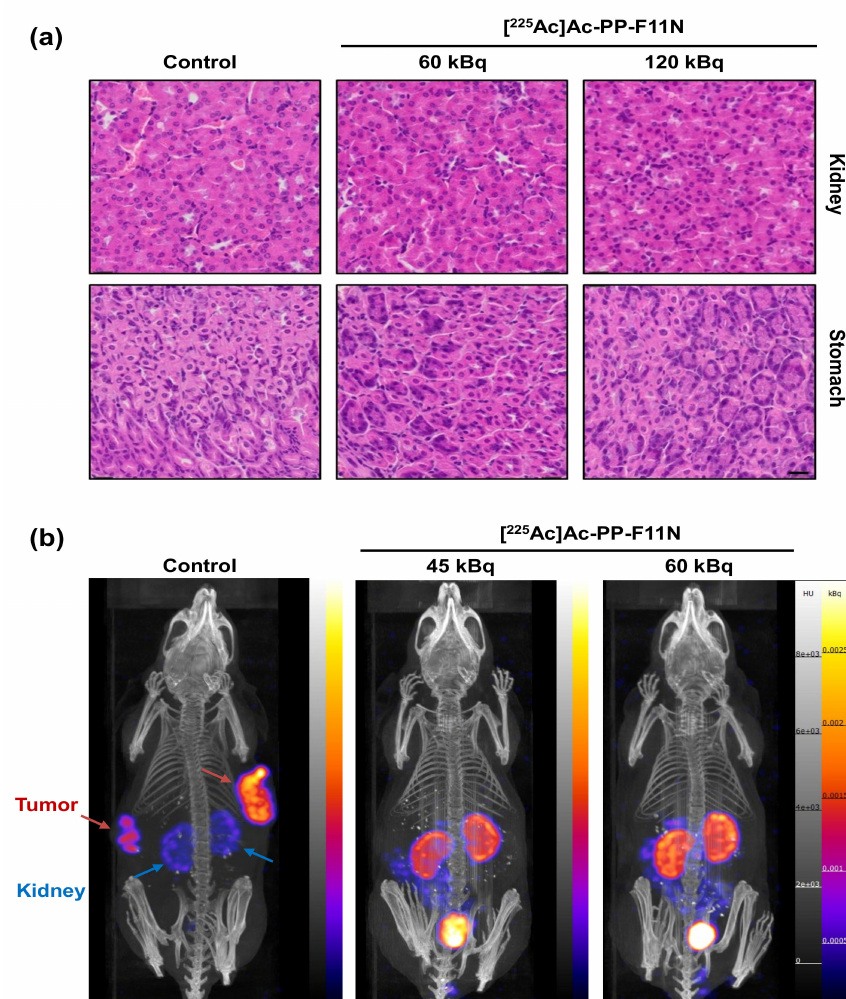
Figure 4. Histological analysis of the kidney and stomach sections an d SPECT / CT imaging after TA ( a ) Representative images of HE stains of the organs isolated from the control, 60, and 120 kBq [ 225 Ac]Ac-PP-F11N-treated A431 / CCKBR xenografted nude mice. Scale bar: 20 µ m. ( b ) SPECT-CT image (left) 20 h post-[ 111 In]In-PP-F11N injection of untreated A431 / CCKBR tumor-bearing mouse. Red and blue arrows indicate tumors and kidneys, respectively. Middle and right, images taken at 2 h post-[ 111 In]In-PP-F11N injection of two mice with no palpable tumors after treatment with 45 and 60 kBq of [ 225